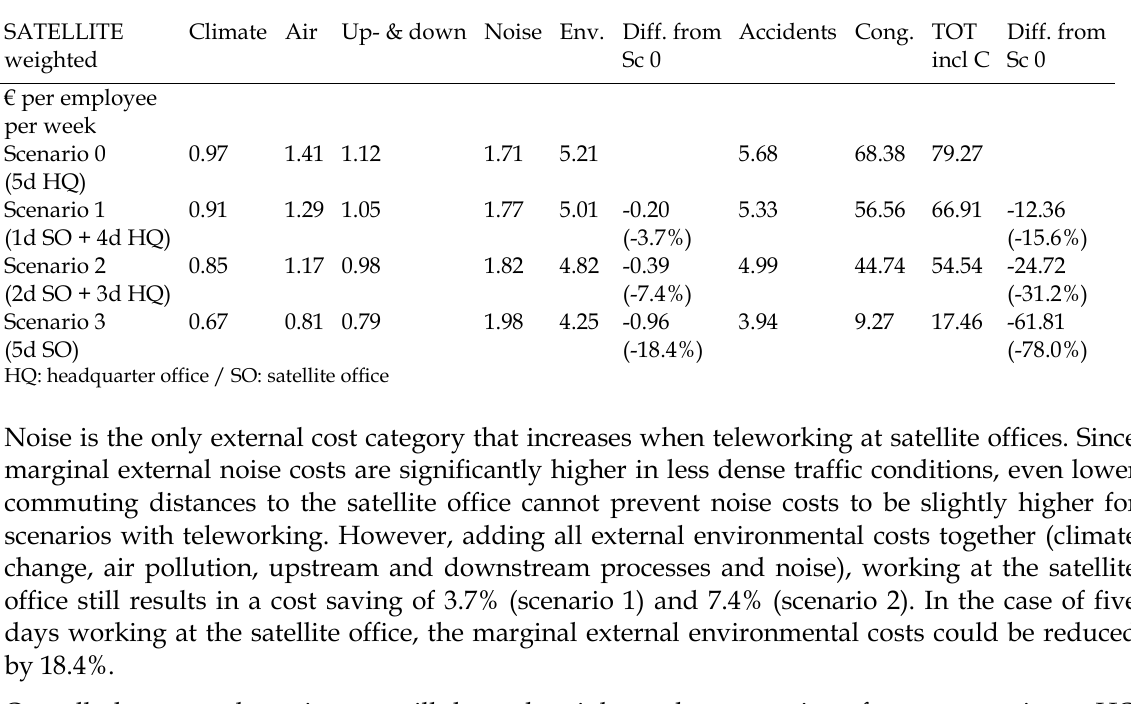
Table 4. Marginal external costs for teleworking at satellite office per employee per week (€ 2011): weighted average of modal categories (MOBI,